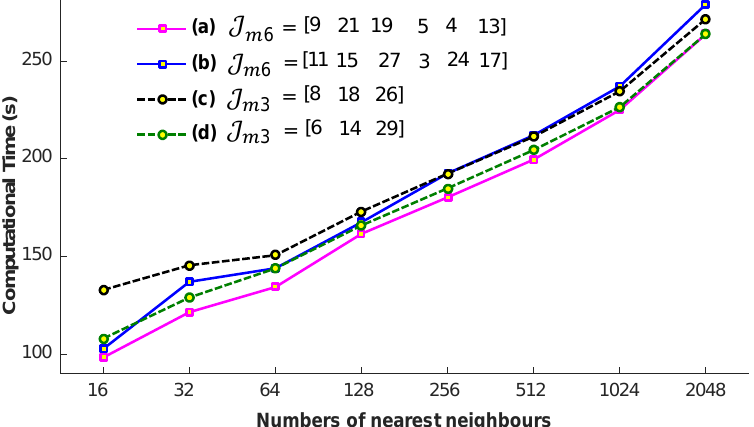
Figure 8. The impact of the number of nearest neighbors in computational time with different missing joint sets J m 6 and J m 3